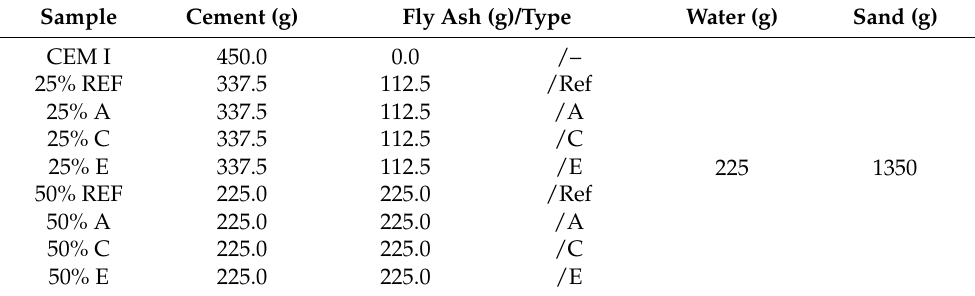
Table 5. Composition of tested mortars.